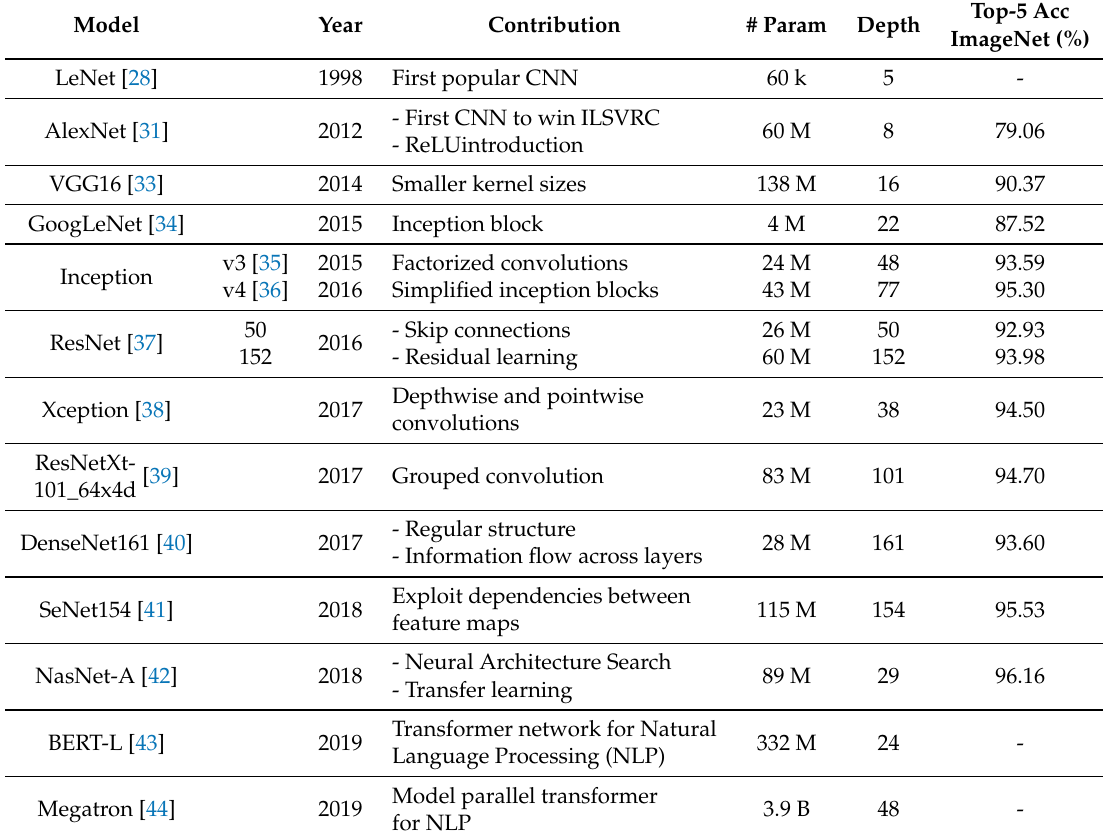
Table 1. Comparison of the most popular models in the history of